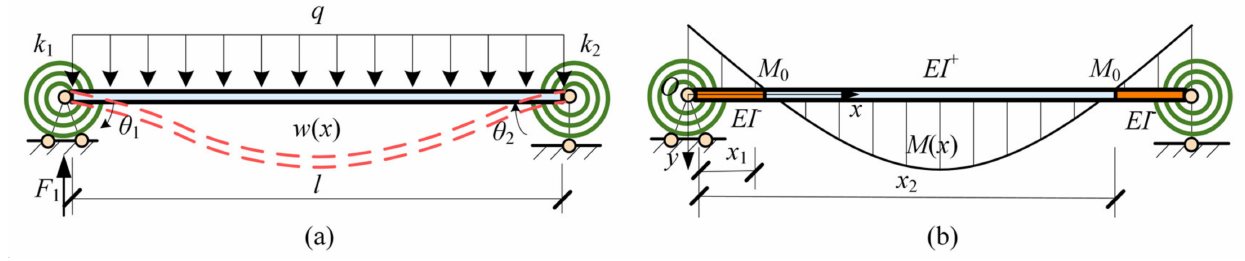
Figure 2. Theoretical model of the composite frame beam under uniform vertical loads. (( a ) Boundary constraints and deformation; ( b ) Moment and section stiffness